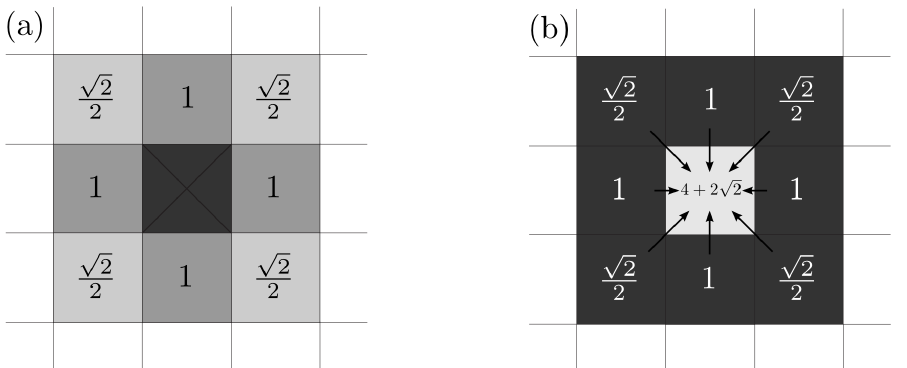
Figure 1. ( a ) Influence of an occupied cell (center) on the adjacent free cells. The weight in the diagonal √ directions is 2/2 for avoiding square-shaped evolutions. ( b ) For a fully surrounded free cell (center), √ its total number of occupied adjacent cells is 4 + 2 2.